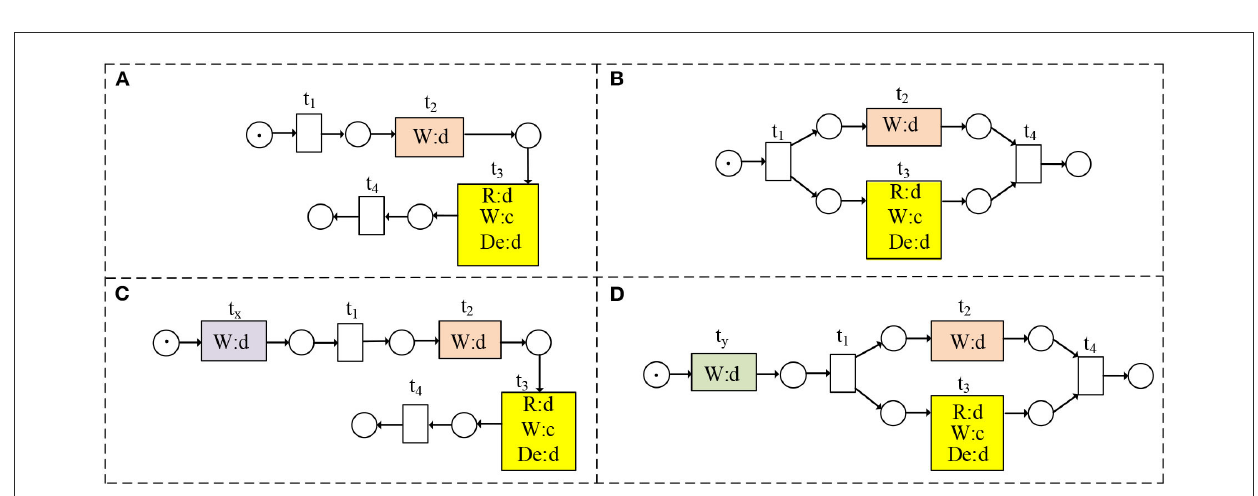
FIGURE8 (A–D) are WFD-net models of Table